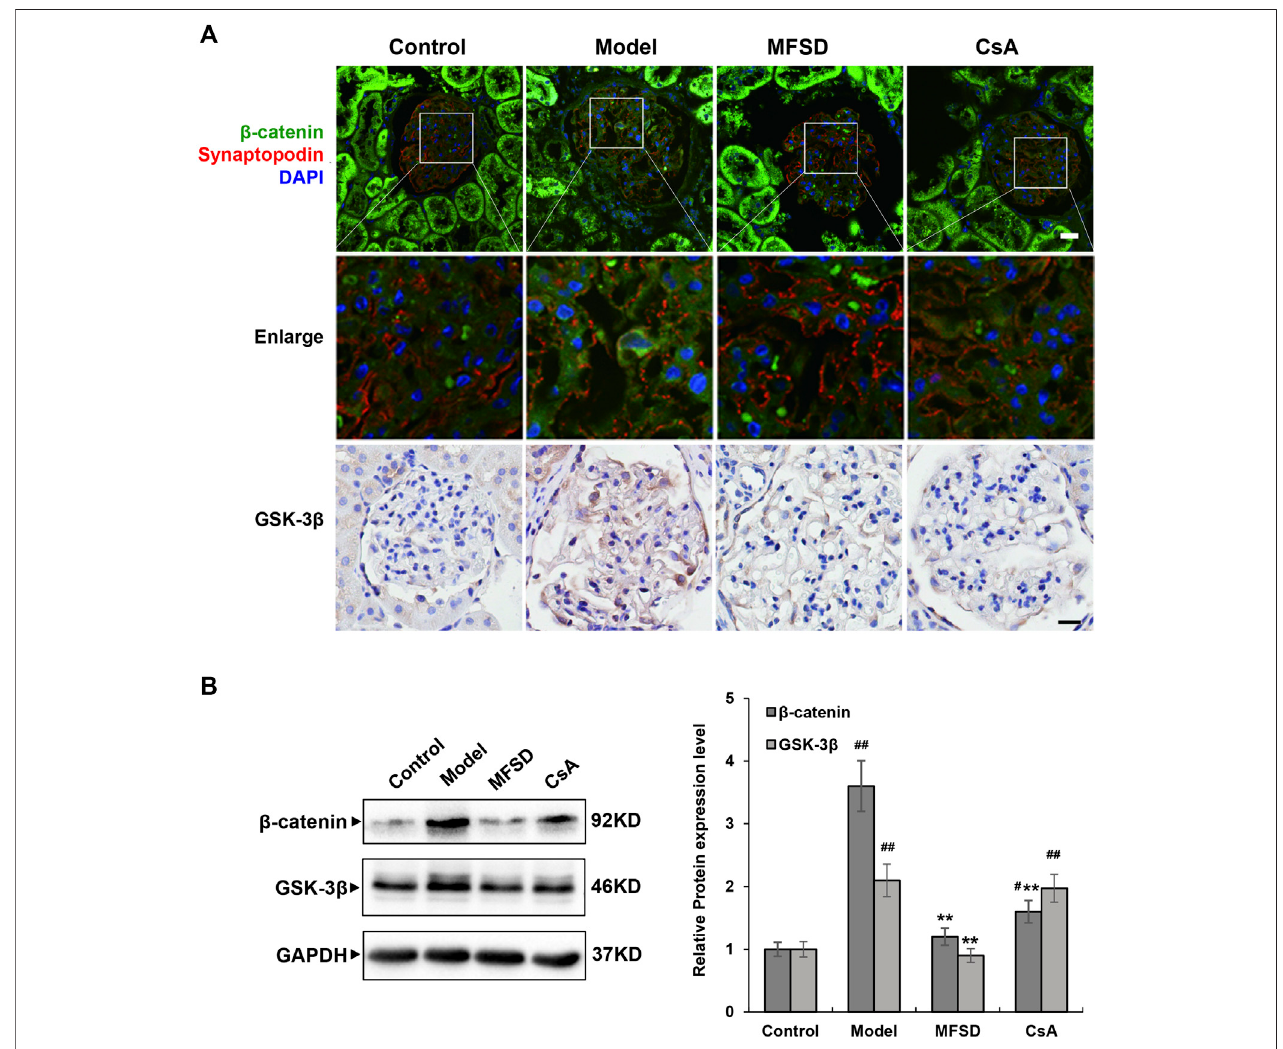
FIGURE 7 | MFSD inhibits the Wnt/ β -catenin pathway in PHN rats (A) Immuno fl uorescent staining of β -catenin-positive puncta (green) accumulated in podocytes of PHN. The podocytes in glomeruli were identi fi ed by immuno fl uorescent double-labeling with synaptopodin (red), a podocyte foot process-speci fi c protein. The nuclei werestainedwithDAPI(blue).ImmunohistochemicalstainingofGSK-3 β wasconductedusingaconfocalmicroscope.Imageswerecollectedunderalightmicroscopeat ×400magni fi cation (scale bar = 20 μ m). (B) The relative protein expression levels of renal β -catenin and GSK-3 β ofPHN rats were analyzed by western blot assay. Therelativeproteinexpressionlevelwasexpressedasthetargetprotein/GAPDHratio.Valuesarerepresentedasmean±SD. # p < 0.05and ## p < 0.01 vs .controlgroup, ** p < 0.01 vs . model